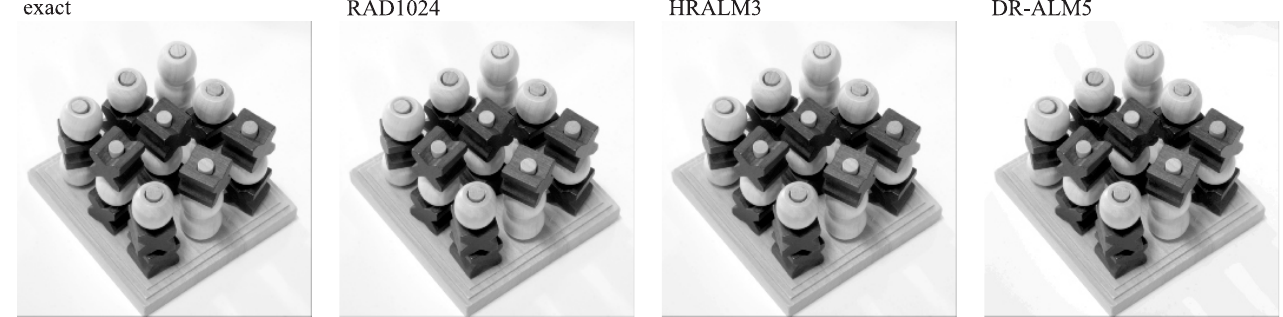
Figure 8. The wood game image smoothing with selected approximate multipliers.